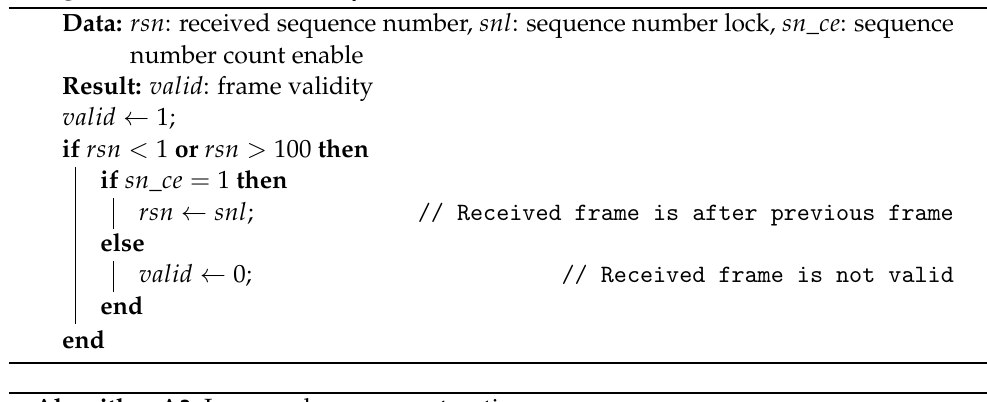
Algorithm A3: Image column